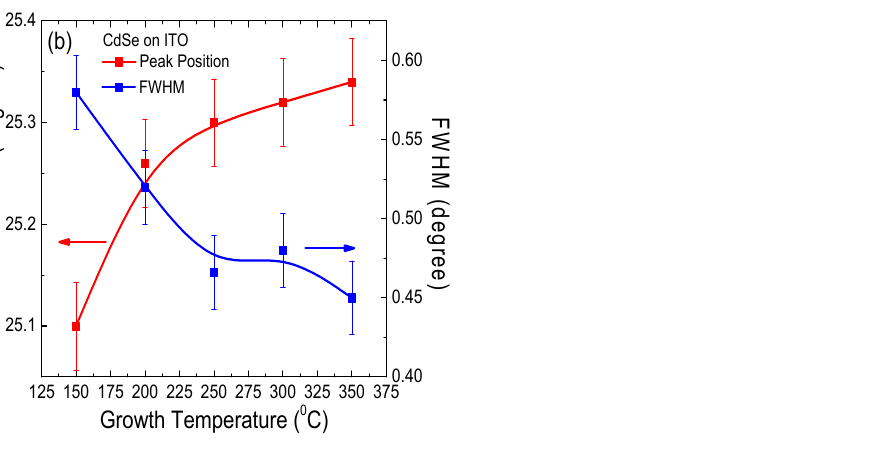
Table 1. CdSe thin film roughness estimation from atomic force microscopy analysis.